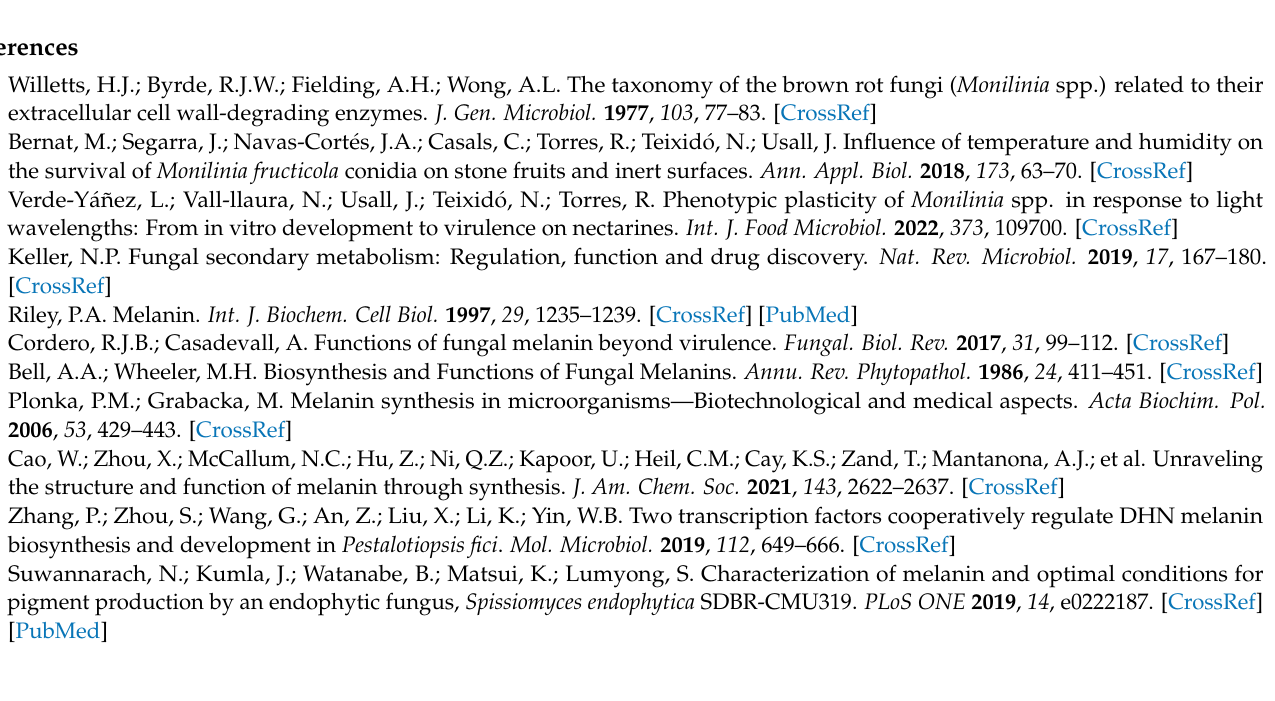
Table S2: Real-time PCR primers set to assess the expression pattern of the selected